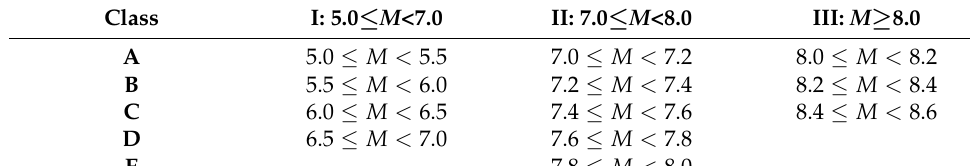
Table 2. Magnitude classes used in computing MMI database. Each class could be simply expressed as XX, where the first X stands for I, II, and III, and the second X stands for A, B, C, D, and E. For example, IA refers to the magnitude class 5.0 ≤ M < 5.5.